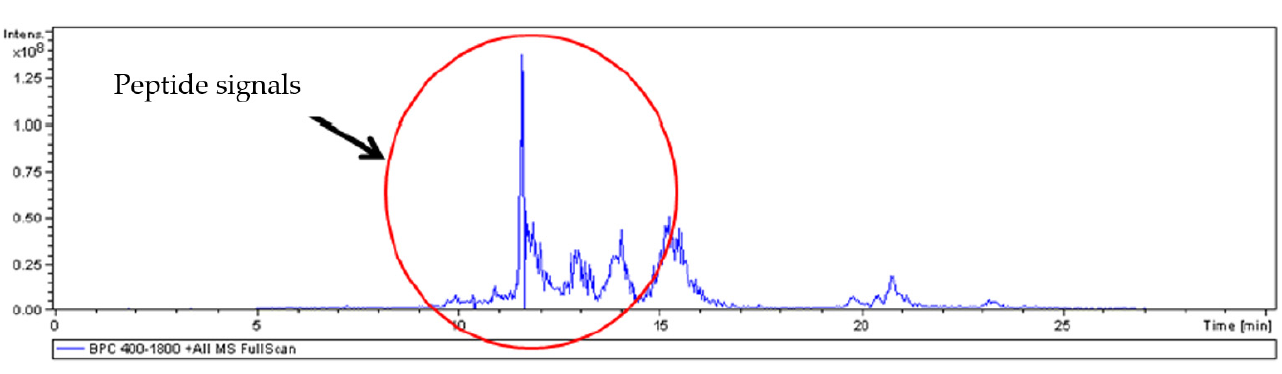
Figure 4. Signal peptide analysis graphic of consensus amino acid sequence of digested WA18 purified mycocin.